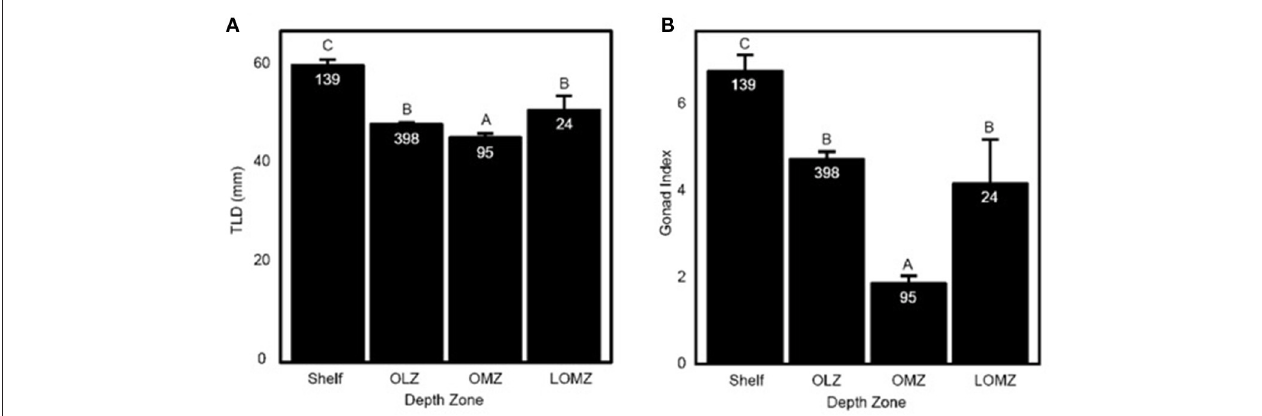
FIGURE 2 | Representation of Strongylocentrotus fragilis traits across depth zones. (A) Total length of diameter (TLD; mm) of tests collected throughout the SCB. (B) Mean Gonad Index (GI). Error bars are standard errors and numbers in barplots are numbers of dissected urchins ( N ). Shelf = < 200m; OLZ = Oxygen Limited Zone (22–60 µ mol oxygen kg − 1 ); OMZ = Oxygen Minimum Zone core ( < 22 µ mol oxygen kg − 1 ); LOMZ = Lower Oxygen Minimum Zone ( > 900m where dissolved oxygen begins to